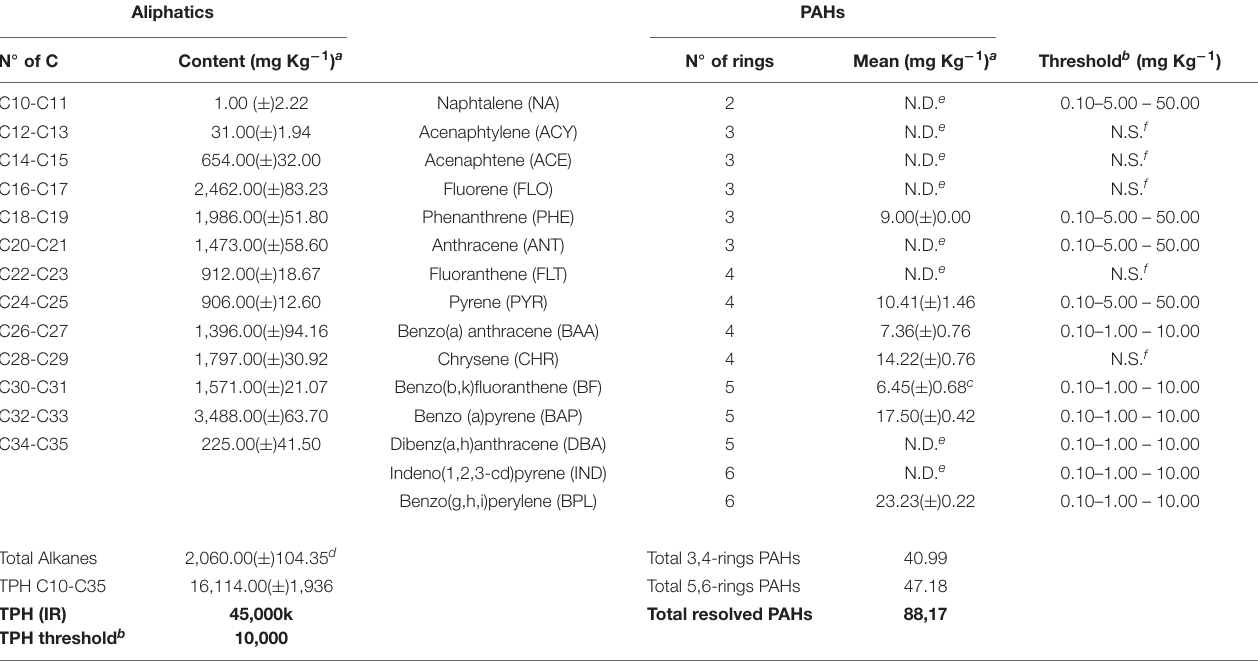
TABLE 1 | Aliphatic and aromatic hydrocarbon composition of the initial contaminated